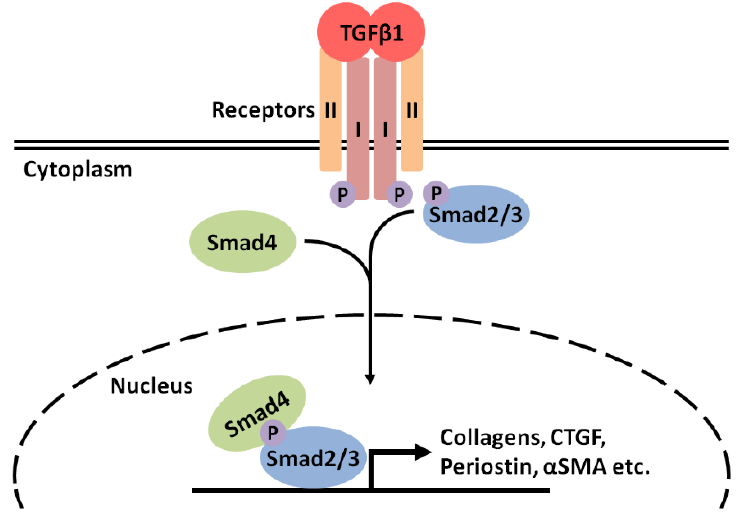
Figure 2. Outline of the canonical TGFβ1 signaling pathway. Upon activation, TGFβ1 binds to its cognate receptor, which consists of two type I (ALK5) and two type II (TGFβRII) subunits. Initial ligand binding is to TGFβRII induces the recruitment of ALK5. TGFβRII subunits phosphorylate ALK5 subunits initiating their activation. ALK5 subunits then phosphorylate the receptor-activated Smad proteins Smads 2 and 3. Phosphorylated Smad2/3 complex with Smad4 and then translocate to the nucleus to facilitate induction of expression of target genes, including profibrotic genes such as those for collagens, CTGF, periostin and αSMA. Canonical myostatin signaling proceeds in an analogous manner, but with different cognate receptors.